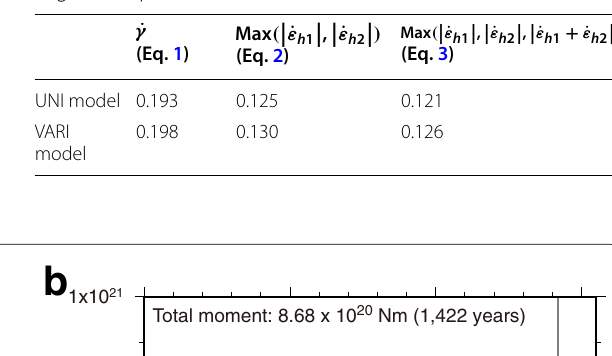
Table 1 Correction coefficient β used to balance the seismic moment calculated from geodetic strain rates to that of past large